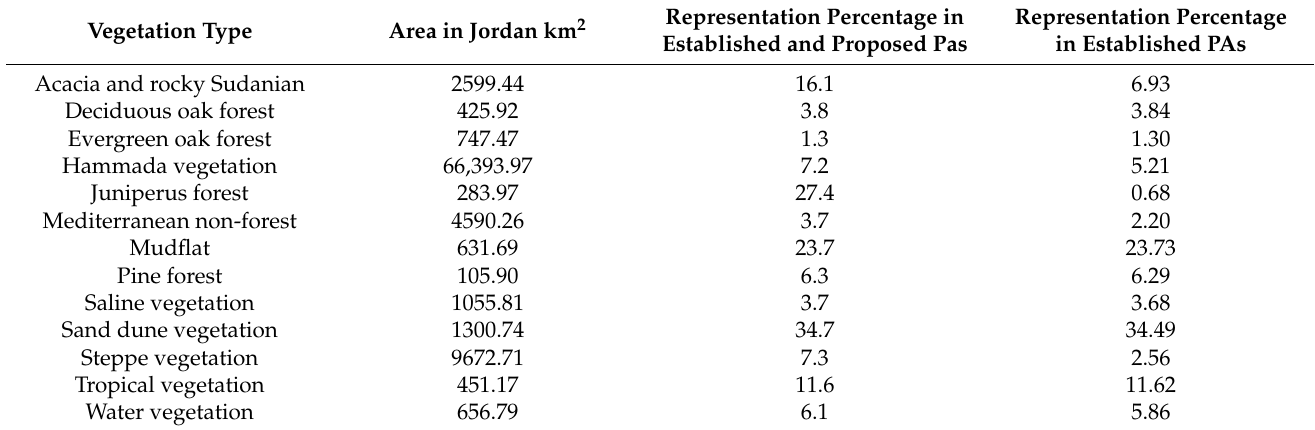
Table 1. The representation percentages for the established and proposed PAs under the current